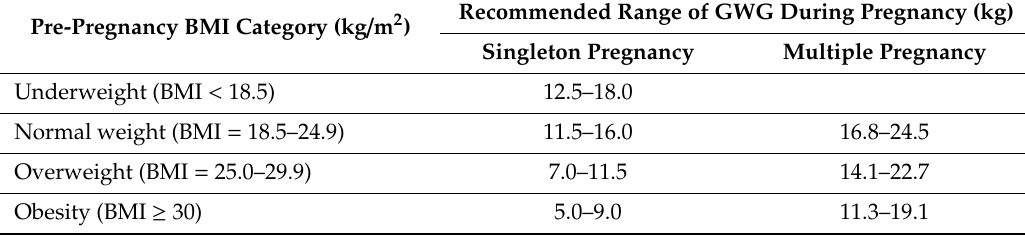
Table A1. Recommendations of GWG according to IOM 2009 [60]: